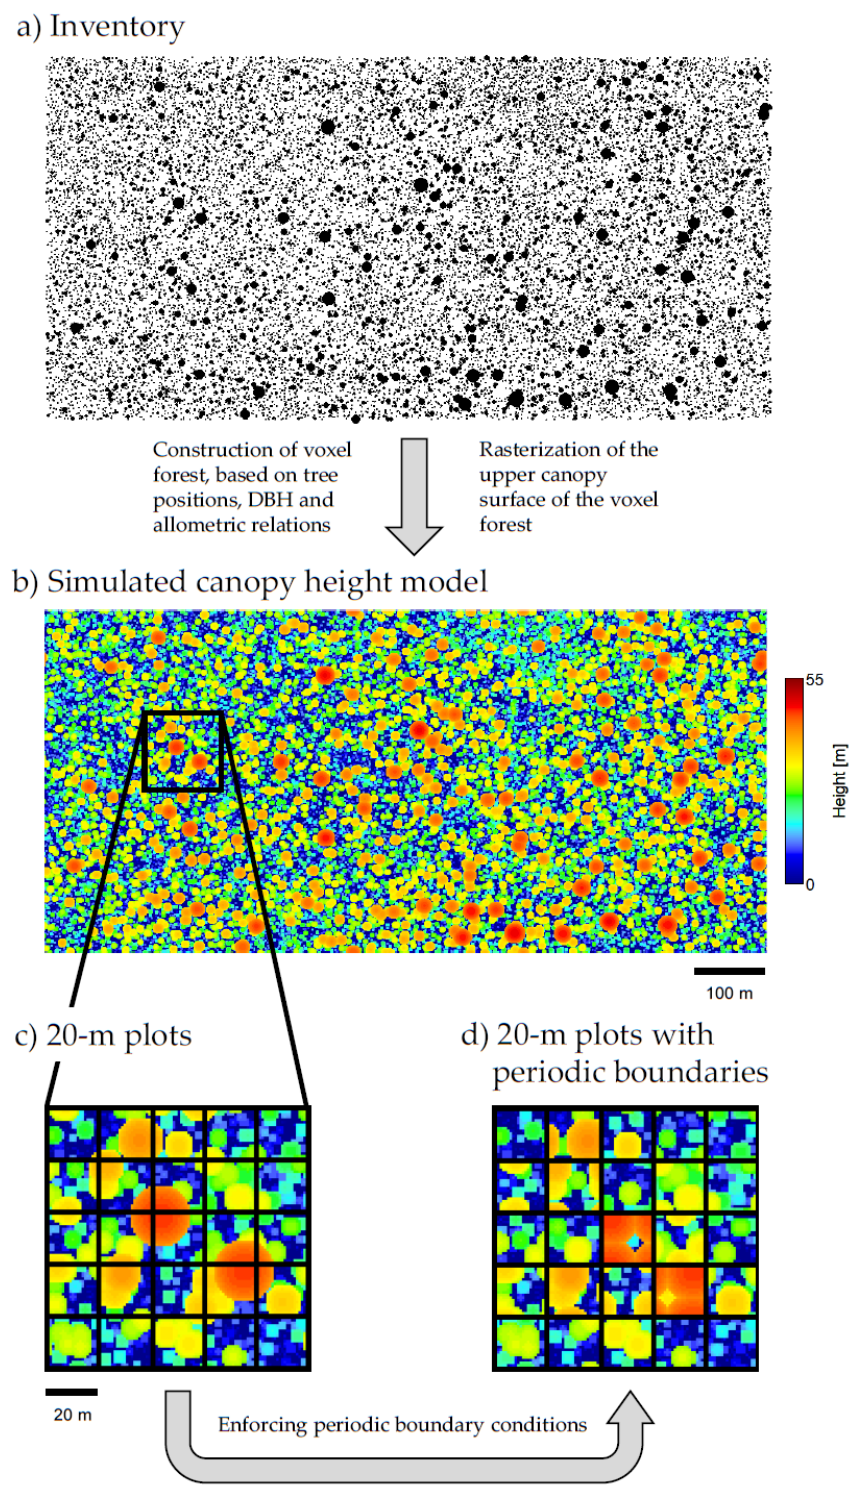
Figure 3. Derivation of the simulated canopy height model (CHM) from the inventory data of the Barro Colorado Island plot. ( a ) The positions of the trees in the 50-ha plot with point sizes proportional to the DBH (only trees with a DBH >10 cm are displayed). ( b ) The upper surface of the voxel forest, which is the simulated CHM. ( c ) A 1-ha example area with a 20-m grid overlay. ( d ) The same example area with periodic boundaries enforced such that the tree crowns, instead of leaving the 20-m plots, reappear at the opposite sides of the plots.